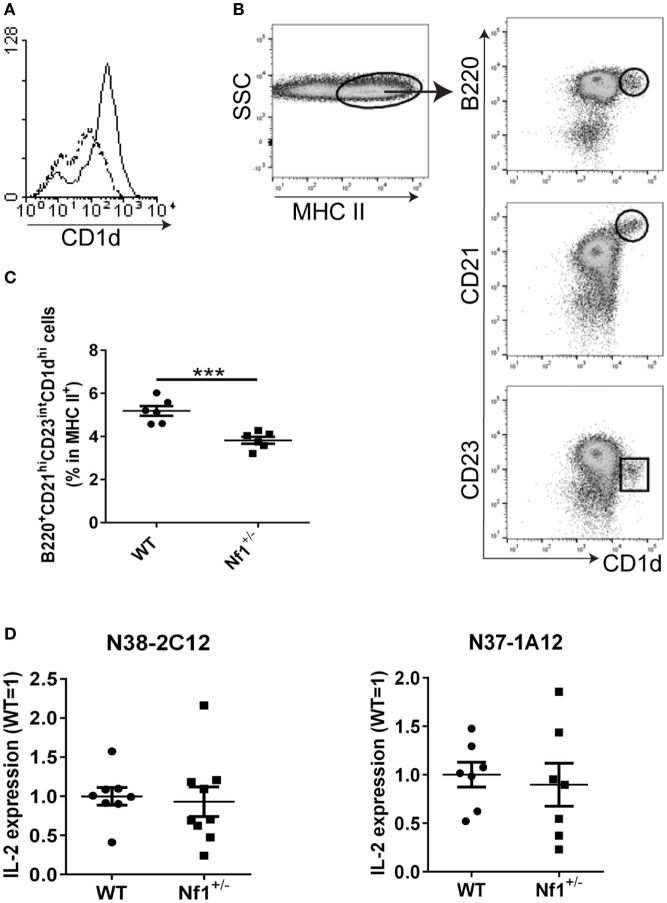
Lower CD1d expression on cells from Nf1+/− mice. (A) Bone marrow-derived dendritic cells (BMDCs) from Nf1+/− and wildtype (WT) mice were fixed and stained with the anti-CD1d mAb, 1B1. CD1d-specific staining from a representative Nf1+/− mouse (dotted line) was overlaid with that of a WT littermate (solid line). (B) Splenocytes from Nf1+/− mice or WT littermates were stained with MHC II-, B220-, CD21-, CD23-, and CD1d-specific antibodies. MHC II+ cells were gated and further analyzed for B220, CD21, CD23, and CD1d expression by flow cytometry. The circled population corresponds to B220+CD21hiCD23intCD1dhi splenocytes. Combined results from multiple experiments are shown in (C). Each dot represents an individual mouse. ***p < 0.001. (D) BMDCs from Nf1+/− mice or WT littermates were cocultured with the NKT-cell hybridomas, N38-2C12 and N37-1A12. The activation of NKT cells by BMDCs was determined by ELISA, measuring IL-2 secretion in the supernatants. The relative levels of IL-2 production in Nf1+/− BMDCs compared with WT (WT = 1) are indicated. Combined results from multiple experiments are shown. The data are plotted as the mean ± SEM. Each dot represents an individual mouse.